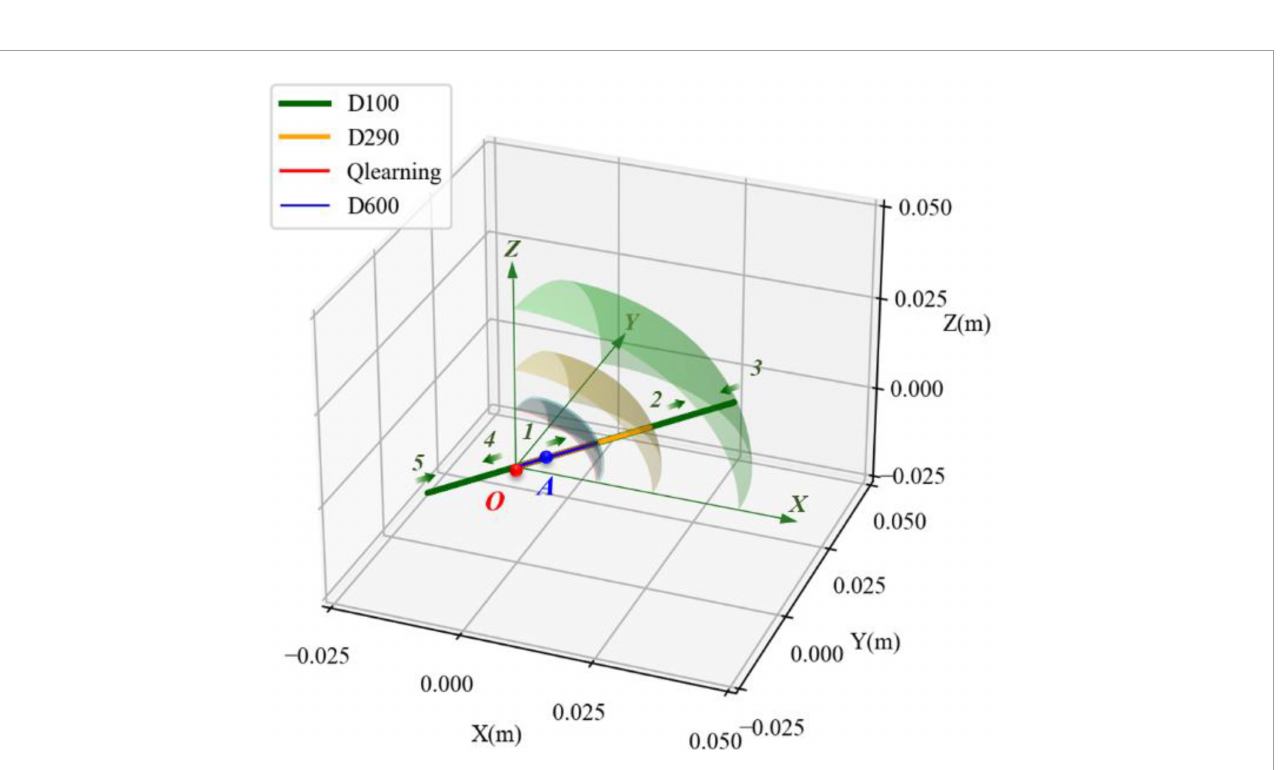
FIGURE10 Comparison of motion trajectories of the robotic end in different damping